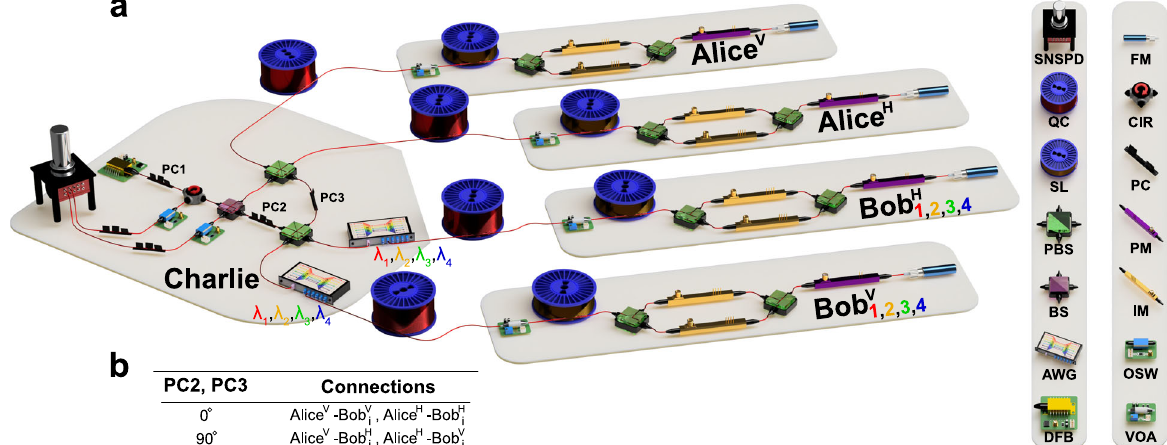
Fig. 5 Full experimental setup of a 2 × N plug-and-play (PnP) twin- fi eld quantum key distribution (TF-QKD) network. a Full experimental setup. Although all pairs of Alice and Bob were presented in the fi gure, only a single pair was implemented and swapped according to the network connection in the experiment. b Network connections based on the modulations of two polarization controllers (PCs). The abbreviation de fi nitions are as follows. DFB distributed feedback laser driver, VOA variable optical attenuator, AWG arrayed waveguide grating, OSW optical switch, BS beamsplitter, PBS polarization beamsplitter, IM intensity modulator, PM phase modulator, SL storage line, QC quantum channel, PC polarization controller, CIR circulator, SNSPD superconducting nano-wire single-photon detector, FM Faraday rotator